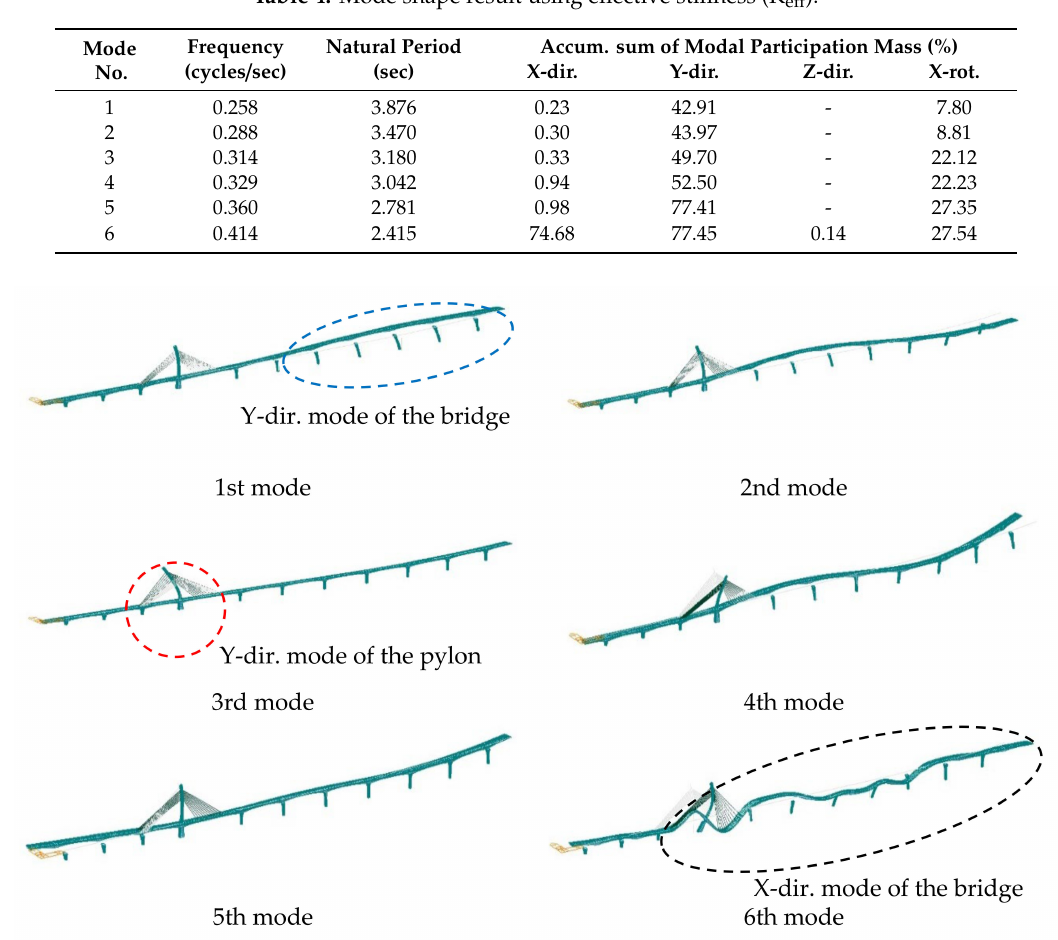
Table 4. Mode shape result using e ff ective sti ff ness (K e ff ).